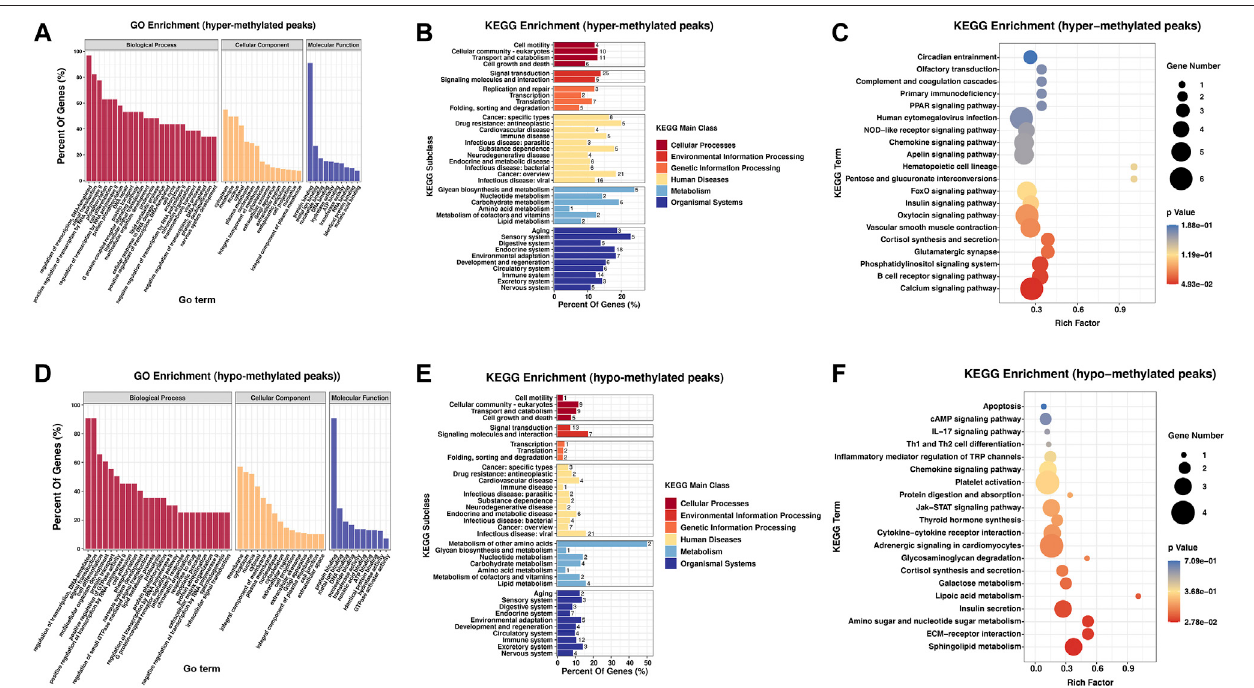
FIGURE 2 | Biological function and pathway analysis of differentially methylated genes between the RA and Con groups. (A) GO enrichment exploration of hypermethylated peaks. (B) KEGG enrichment subclass analysisofhypermethylated peaks. (C) Top20KEGGpathwaysexplorationofhypermethylatedpeaks. (D) GO enrichmentexplorationofhypomethylatedpeaks. (E) KEGGenrichmentsubclassanalysisofhypomethylatedpeaks. (F) Top20KEGGpathwaysinthehypomethylated peaks. RA, rheumatoid arthritis; Con, control group; GO, Gene Ontology; and KEGG, Kyoto Encyclopedia of Genes and Genomes.